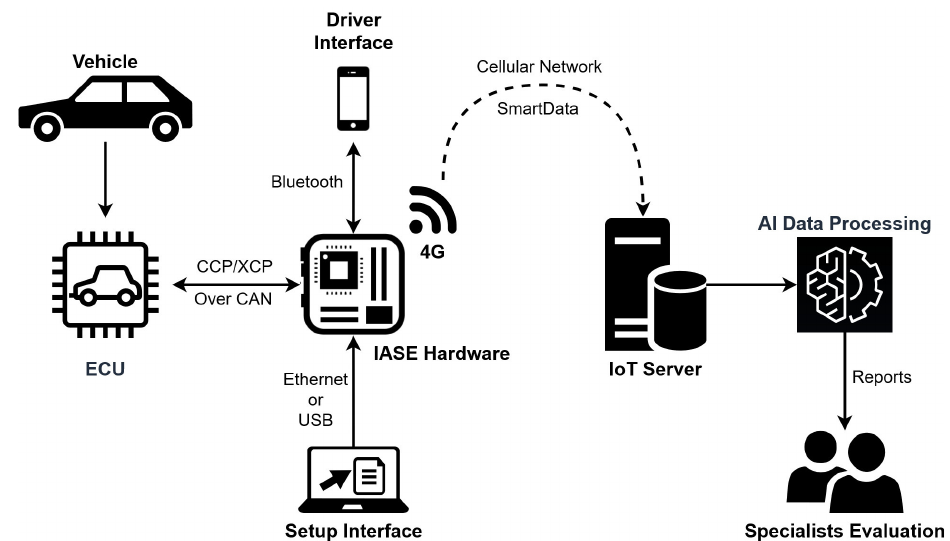
Figure 1. IASE Data Flow